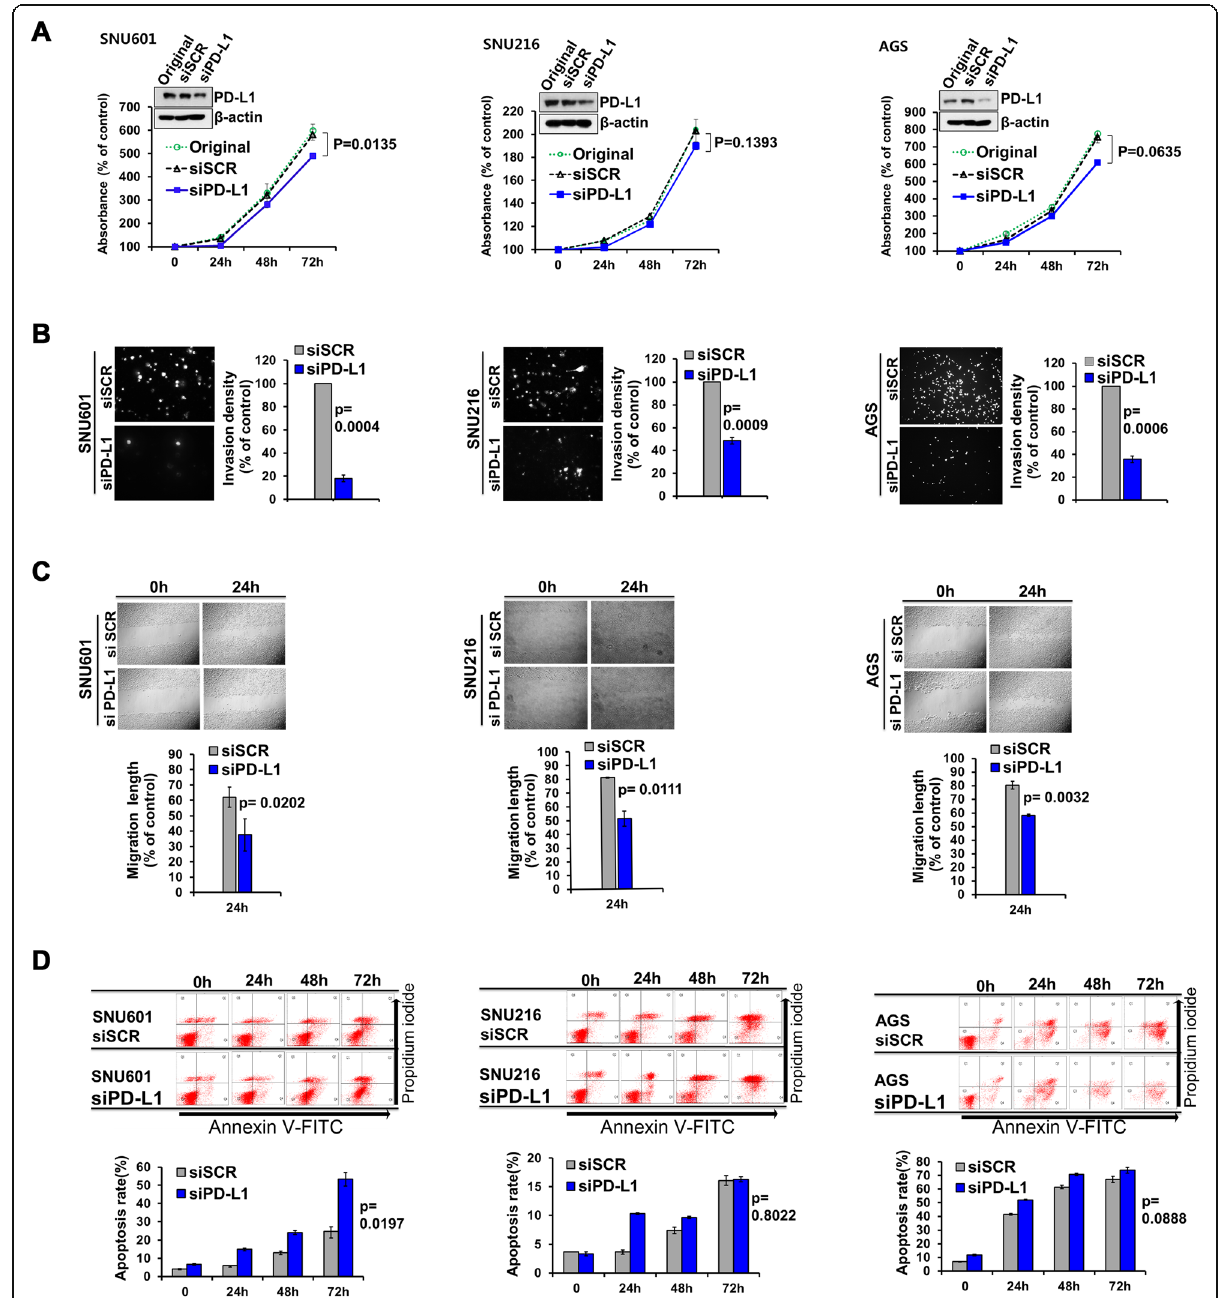
Fig. 6 Effect of PD-L1 knockdown on cell biologic properties in EBV-negative gastric carcinoma cell lines. SNU 601 cells (in left column) show lower cell proliferation ( a ), invasion ( b ) and migration ( c ), and higher apoptosis ( d ) in PD-L1-specific siRNA cells than scrambled siRNA-transfected mock cells ( P < 0.05). However, in SNU216 cells (in middle column) and AGS cells (in right column), PD-L1-specific siRNA cells reveal statistically significant decreases in invasion and migration compared to scrambled siRNA-transfected mock cells ( P < 0.05), but not statistically significant changes in proliferation and